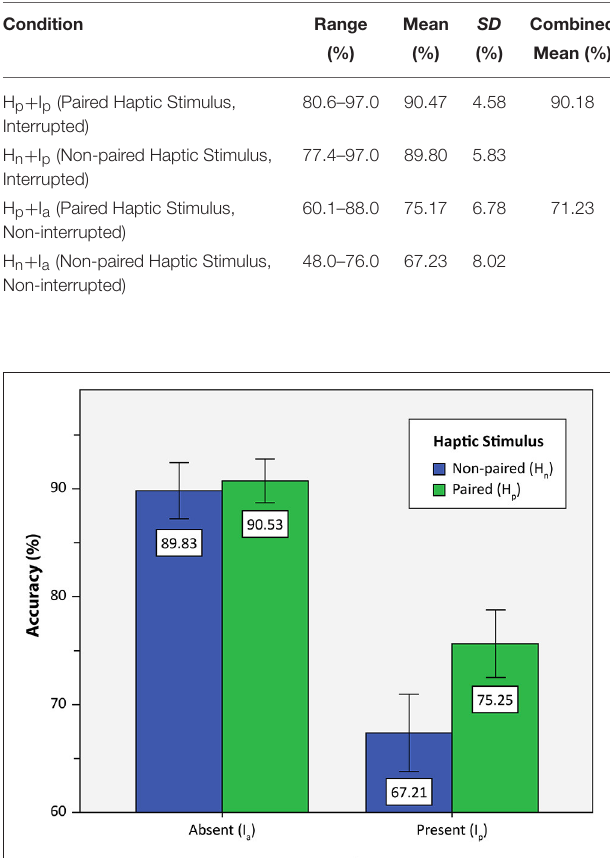
primary two-back task decreased significantly [ F (1, 20) = 237.100, MSE = 31.801, p < 0.01, η 2 = 0.922]. In addition,